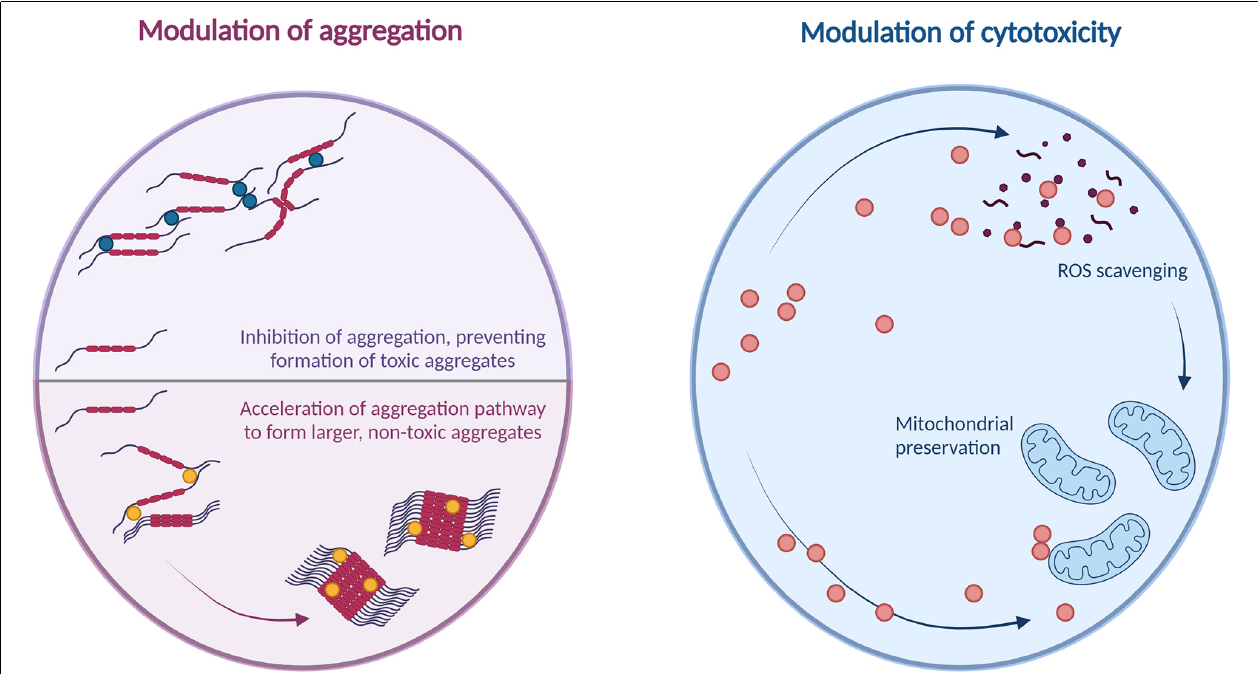
FIGURE 4 | Summary of potential cytoprotective mechanisms of arginine and cationic arginine-rich peptides against amyloids.